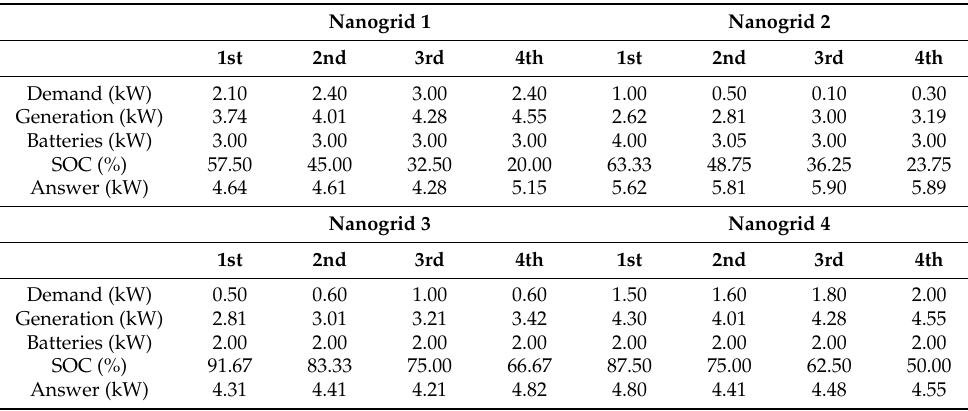
Table 5. Operation planning of HEMS1-4 in order to provide a service.